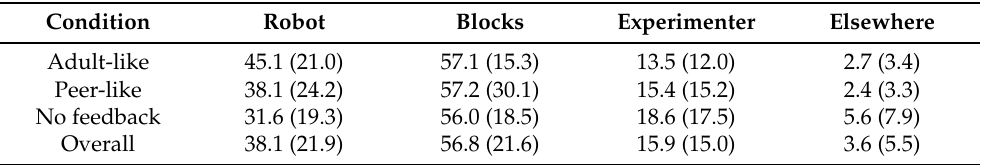
Table 2. The mean duration in seconds for the children’s eye-gaze direction divided into each feedback condition (SD between brackets). Condition Robot